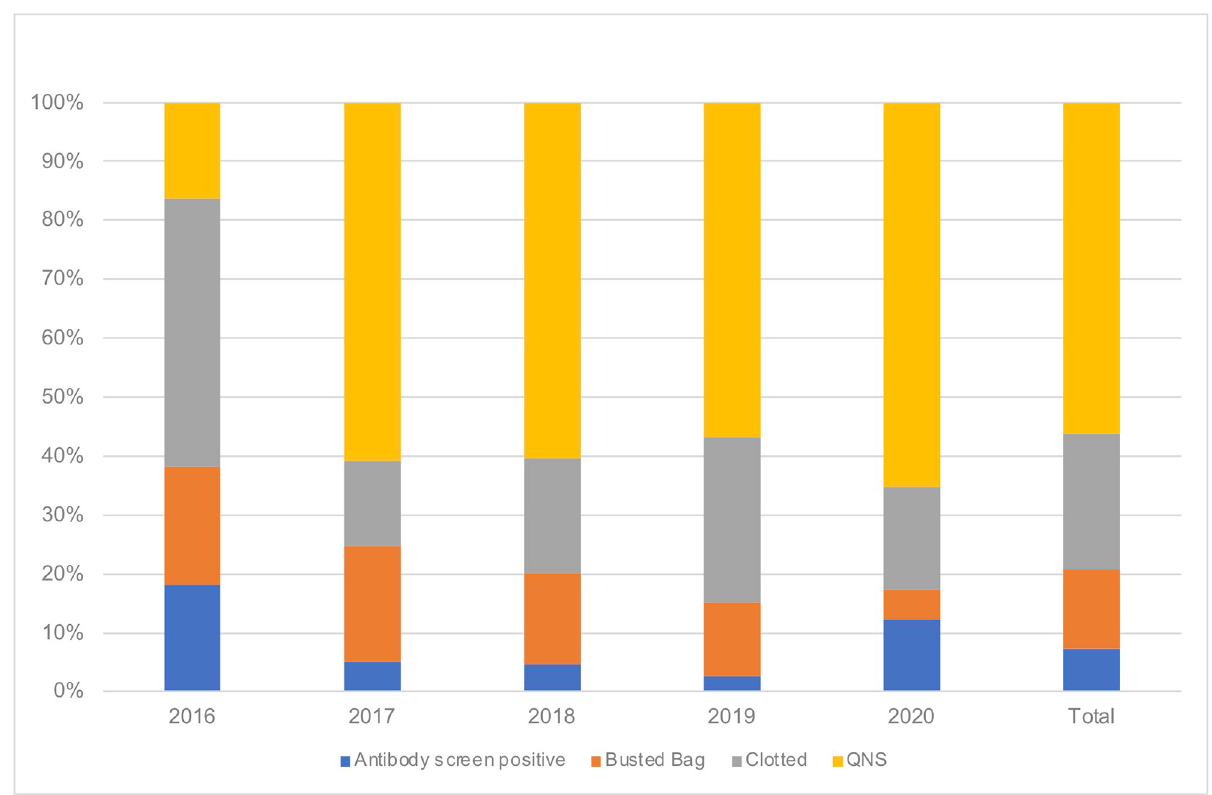
Fig 2. Non-infectious causes of discarding blood per year from 2016–2020 and total cohort. The percentage of antibody screen (blue), busted bag (orange), clotted units (grey), and quantity not sufficient (yellow). QNS: quantity not